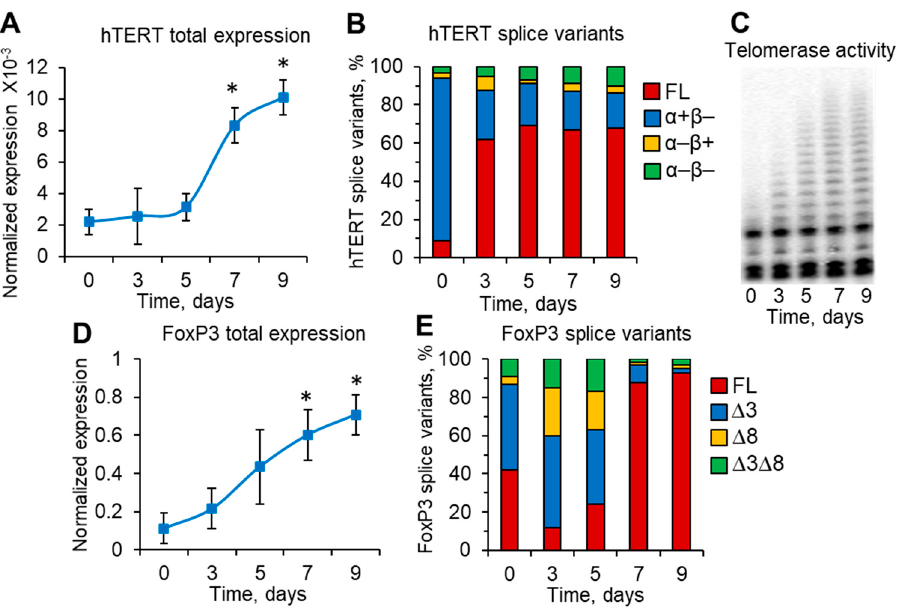
Figure 4. Upregulation of telomerase and FoxP3 is associated with the induction of alternative splicing of their mRNA: ( A ) Induction of total hTERT expression during the time of cell cultivation. ( B ) Changes in the proportion of hTERT splice variants. ( C ) Representative TRAP gel electrophoresis demonstrating elevated telomerase activity in Tregs upon maturation. ( D ) Gradual increase in FoxP3 gene expression during the time course of Treg maturation. ( E ) Changes in the proportion of FoxP3 splice variants. n = 4. * p ≤ 0.05 vs. initial cells at 0-day time-point. FL, full-length variant. α or β indicates corresponding splice variants (see main text). ∆ indicates the deletion of the relevant exon.